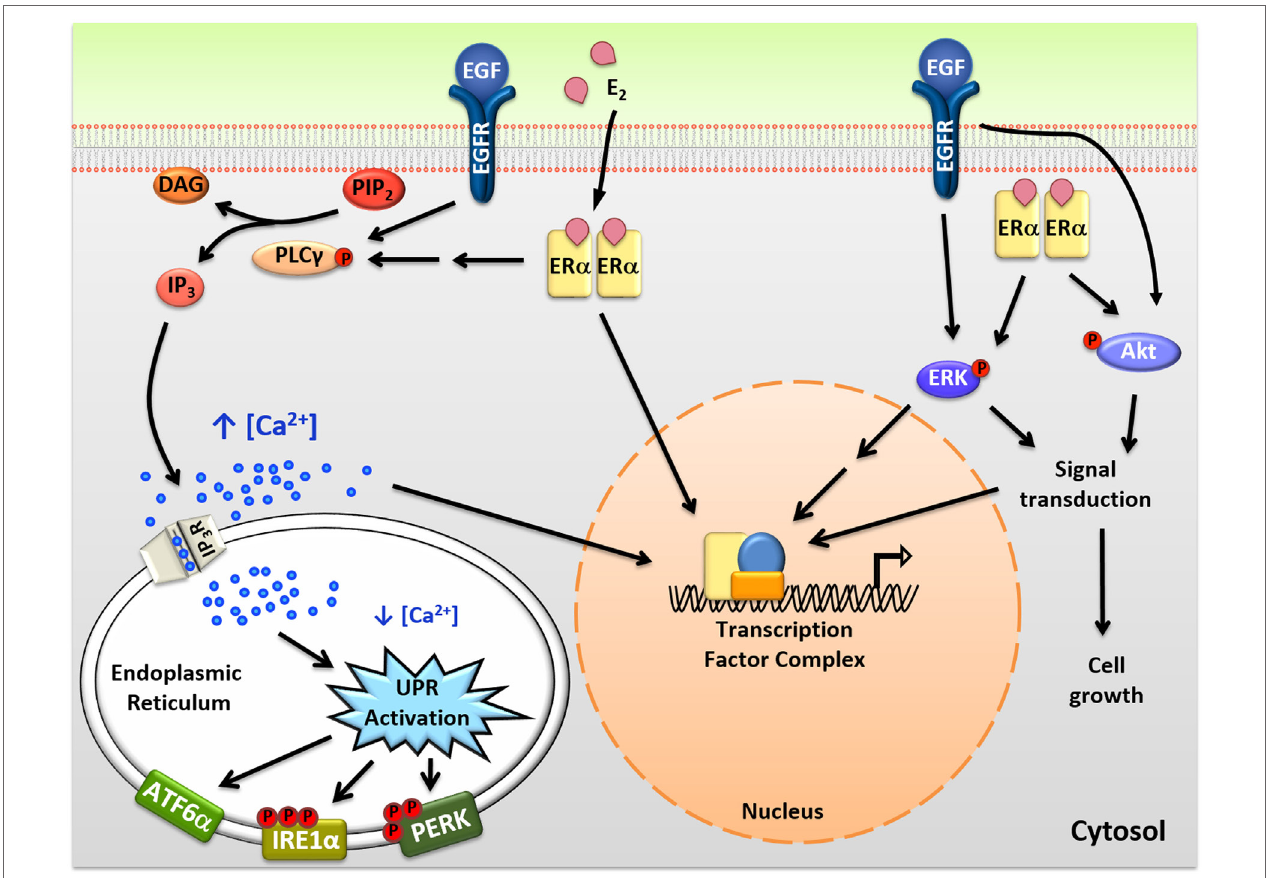
FiGURe 1 | Intracellular actions of mitogenic hormones. Estrogen (E 2 ) and epidermal growth factor (EGF) act on their respective receptors, estrogen receptor α (ER α ), and EGF receptor (EGFR), to initiate crosstalk between extranuclear signaling pathways and their genomic programs. ER α indirectly and EGFR directly activate phospholipase C γ (PLC γ ), resulting in cleavage of PIP 2 to DAG (diacylglycerol) and IP 3 (inositol triphosphate). IP 3 then binds to IP 3 receptors (IP 3 Rs) in the endoplasmic reticulum (EnR) membrane, causing moderate efflux of calcium from the lumen of the EnR into the cell body. This calcium signal activates all three arms of the unfolded protein response (UPR) and acts as an authorizing signal for E 2 -ER α and EGF-EGFR modulation of gene expression and cell proliferation. In parallel, E 2 -ER α and EGF-EGFR modulate additional extranuclear signal transduction pathways, including activation of ERK and Akt signaling. Activation of these pathways is also important for subsequent cell proliferation and crosstalks with the E 2 -ER α and EGF-EGFR genomic